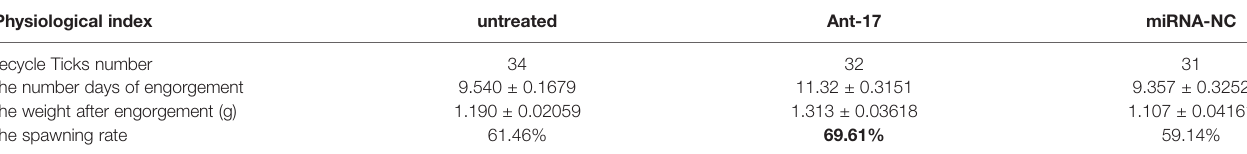
TABLE 4 | Physiological index of ticks in the nov-mir-17 silencing